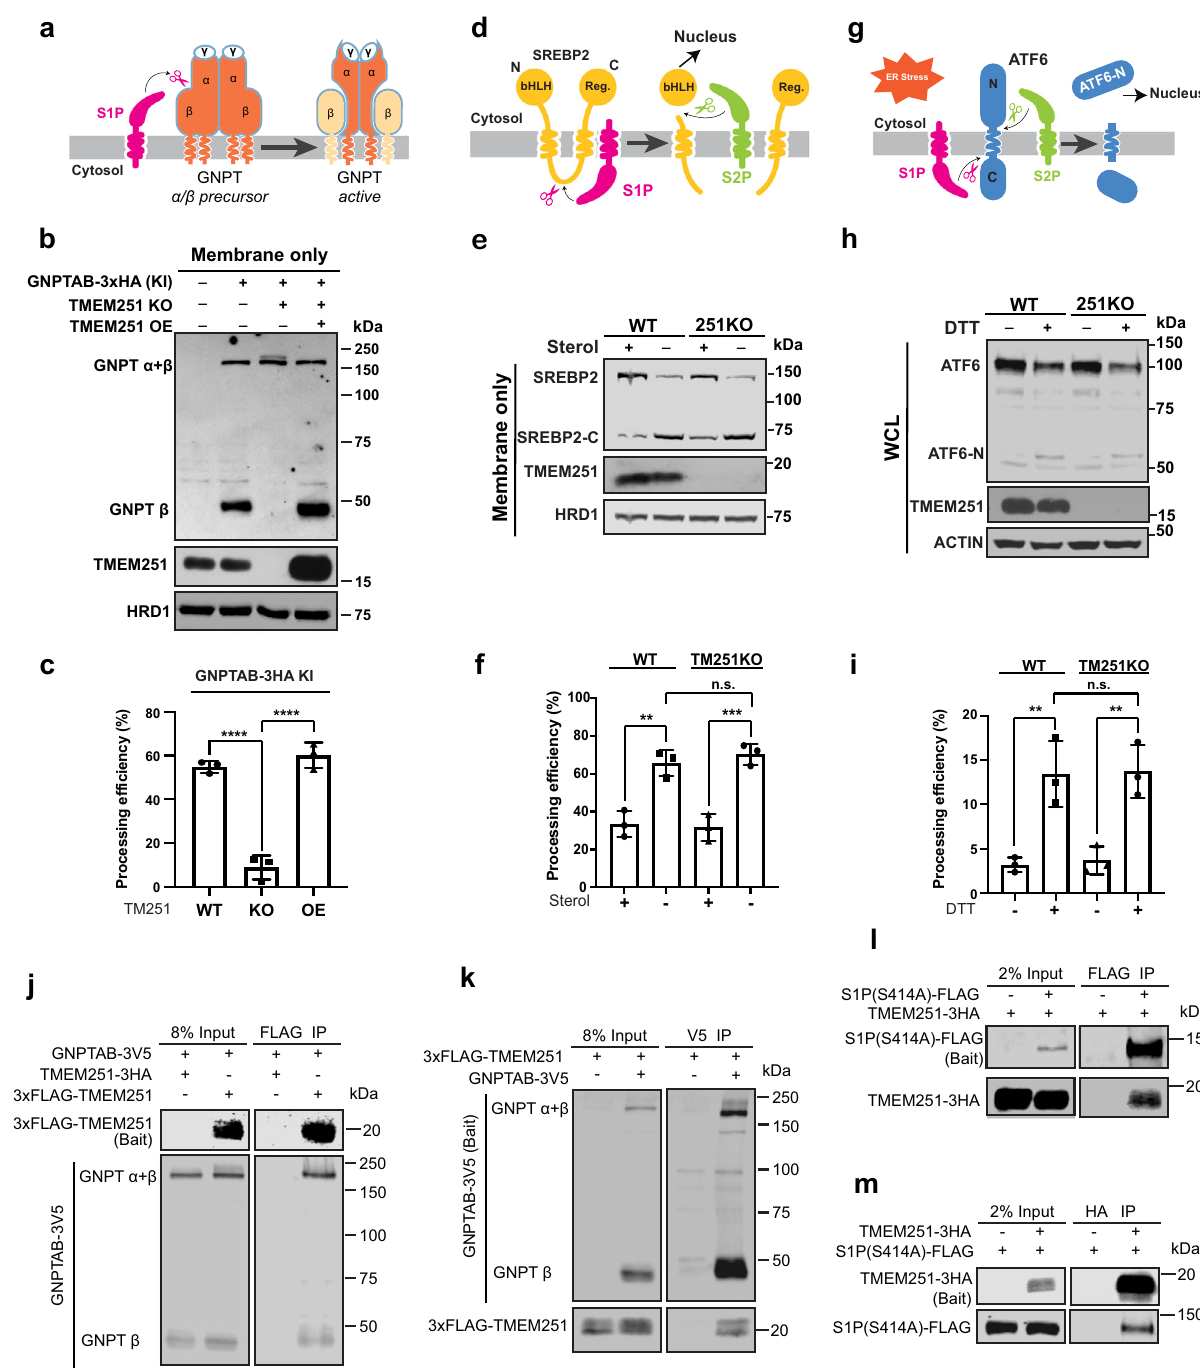
Fig.6|TMEM251isrequiredfortheef fi cientprocessingofGNPT α / β precursor by S1P. a A schematic representation of GNPTAB processing by S1P. b The pro- cessing of the endogenously tagged GNPTAB in TMEM251 KO and TMEM251 overexpression (OE) cells. c Quanti fi cation of the GNPTAB processing ef fi ciency in b . Mean of 3 independent replicates is shown. Error bars represent standard deviation. **** p ≤ 0.0001. d A schematic representation of SREBP2 processing by S1P and S2P. e The processing of SREBP2 in HEK293T WT and TMEM251 KO cells. f Quanti fi cation of the SREBP2 processing ef fi ciency in e . Mean of 3 independent